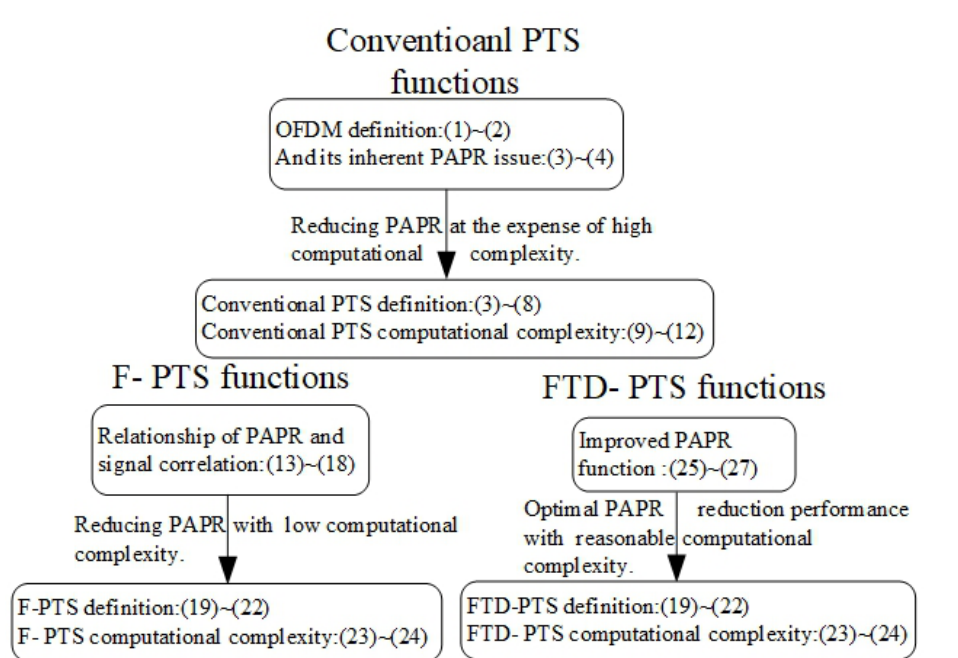
Figure 8. Overview of all functions introduced in this paper.